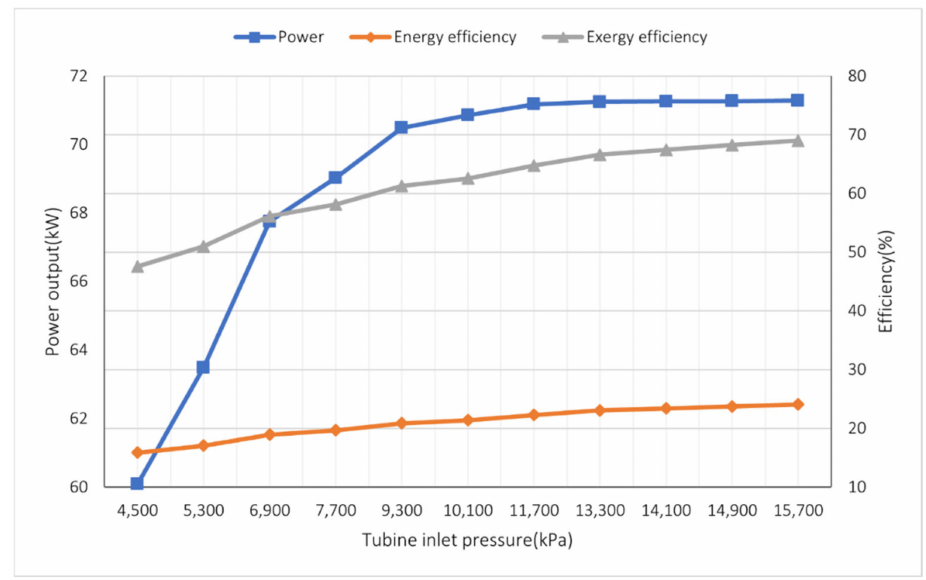
Figure 11. Influence of the turbine inlet pressure on the R152a ORC.